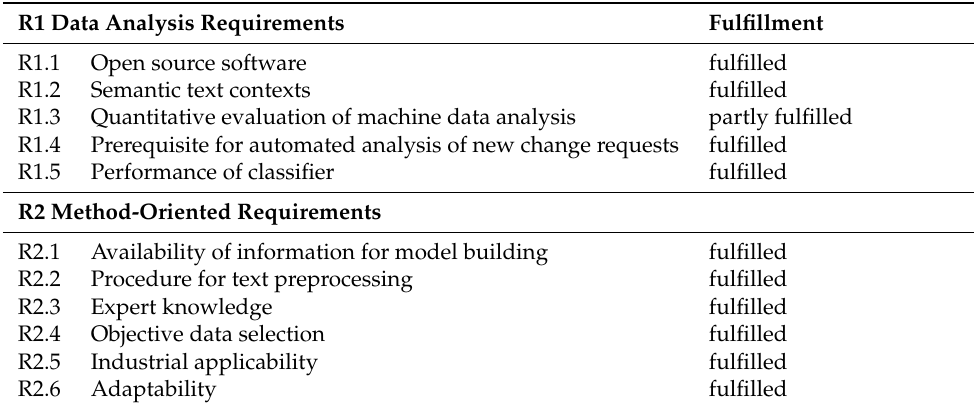
Table 3. Overview of the fulfillment of